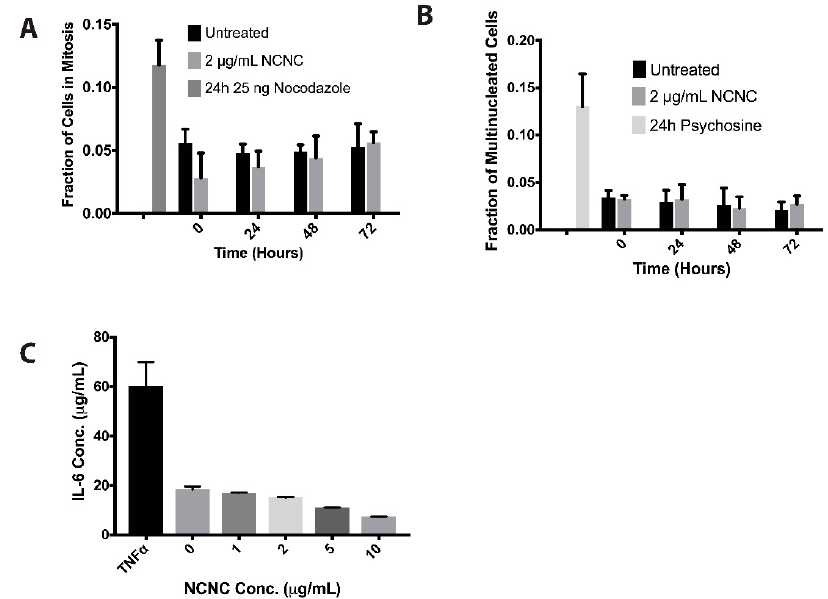
Figure 2. Mitotic and inflammatory response assays on HeLa cells treated with NCNCs. ( A ) HeLa cells were treated with 2 µ g / mL NCNC over a span of 72 h. Mitotic indices were counted at 24-h intervals. HeLa cells were treated with 25 ng nocodazole for 24 h as a positive inducer for mitotic arrest, n = 3 separate experiments. ( B ) HeLa cells were treated with 2 µ g / mL NCNCs over a span of 72 h. Multinucleation frequency was counted at 24-h intervals. HeLa cells were treated with 35 µ M psychosine for 24 h as a positive induce of cytokinesis failure, n = 3 separate experiments. ( C ) HeLa cells were treated with increasing concentrations of NCNCs for 24 h. The supernatants were collected and assayed using an ELISA to probe for IL-6 secretion. 1 ng / mL of TNF α was used as a positive control for secretion of IL-6, n = 2 readings for each concentration.